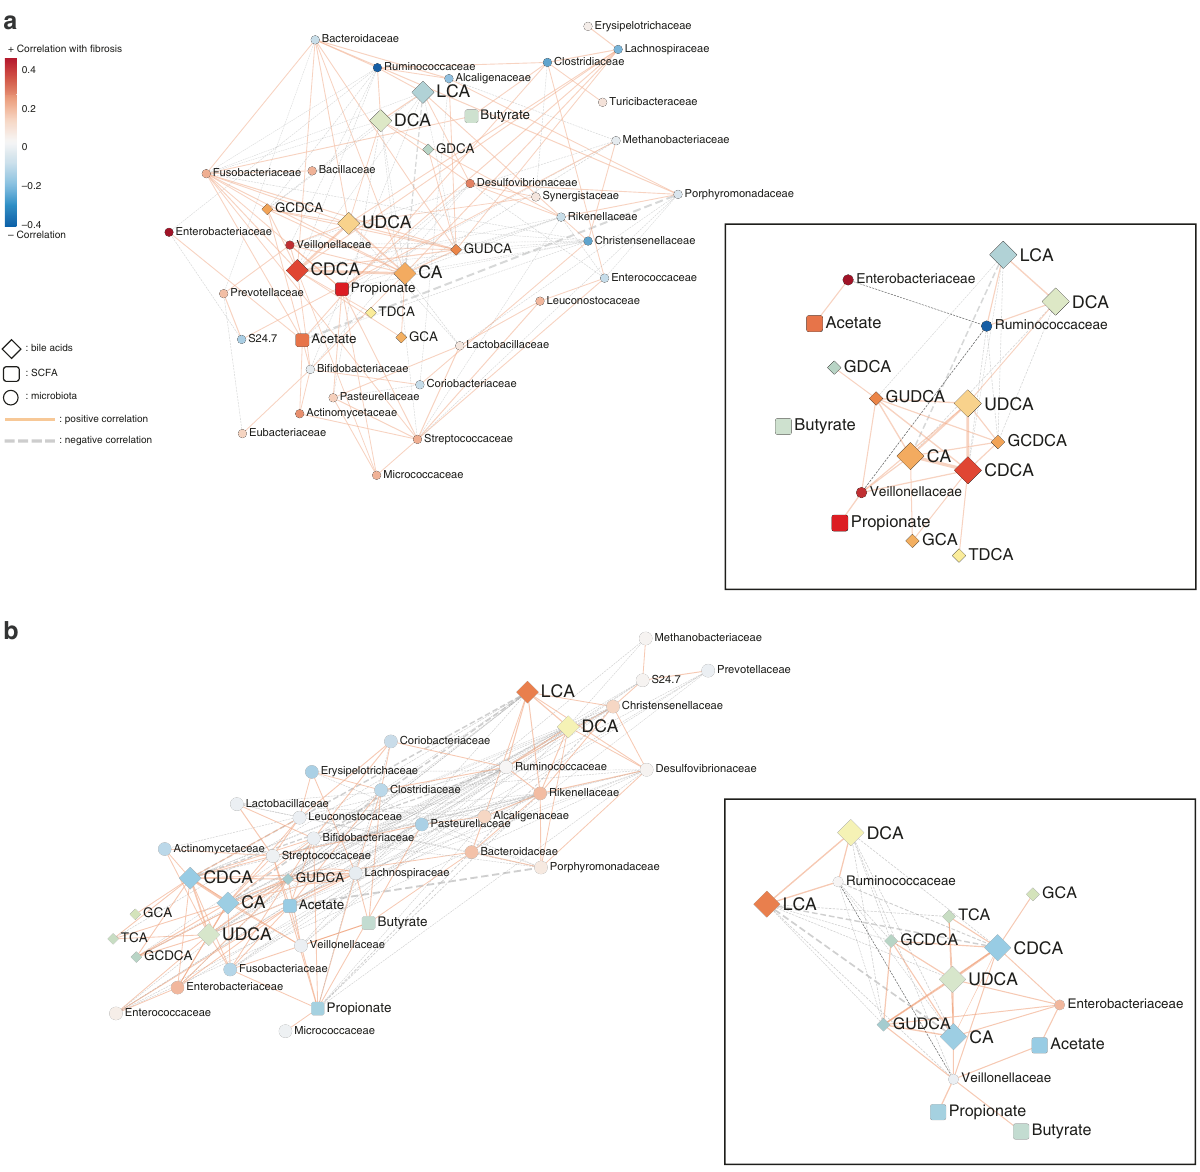
Fig. 4 Network pro fi les between microbial taxa and stool metabolite components in non-obese and obese subjects. Co-occurrence coef fi cients among family-level microbiome components and stool metabolites were calculated by SparCC, and networks ( P < 0.05) are depicted using Cytoscape. a Non- obese and b obese. The solid line (orange) and dotted line (gray) indicate positive and negative correlations, respectively. The shape of the node denotes the components used in this study (ellipse: microbiome, diamond: stool bile acids, and round rectangle: SCFAs) and the color indicates the degree of correlation with fi brosis severity. The P -value for each coef fi cient was obtained by bootstrapping the dataset 500 times and applying SparCC to each of those 500 datasets. Source data are provided as a Source Data fi